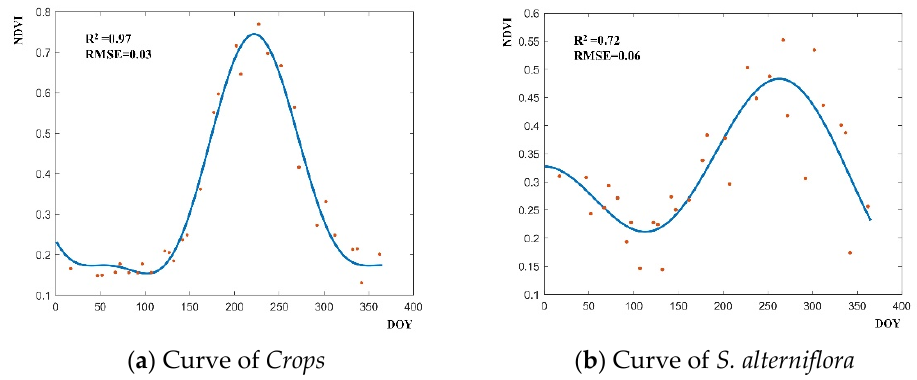
Figure 11. User accuracy of different classification methods.